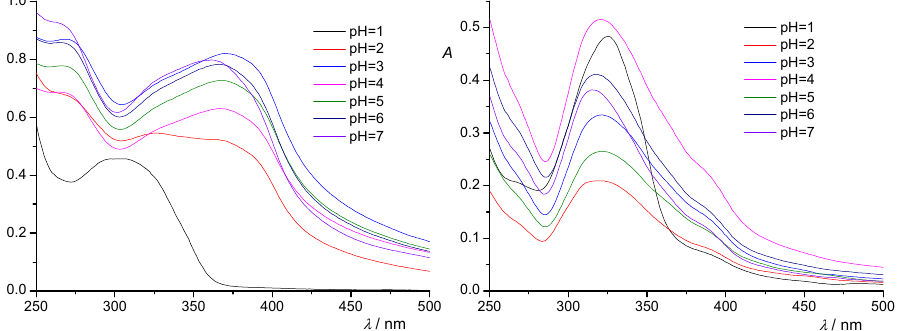
Figure 2. Changes in the UV spectra of compound trans - 3 ( left ) and trans - 4 ( right ) as a function of pH in buffer aqueous solution for pH from 7 to 1.